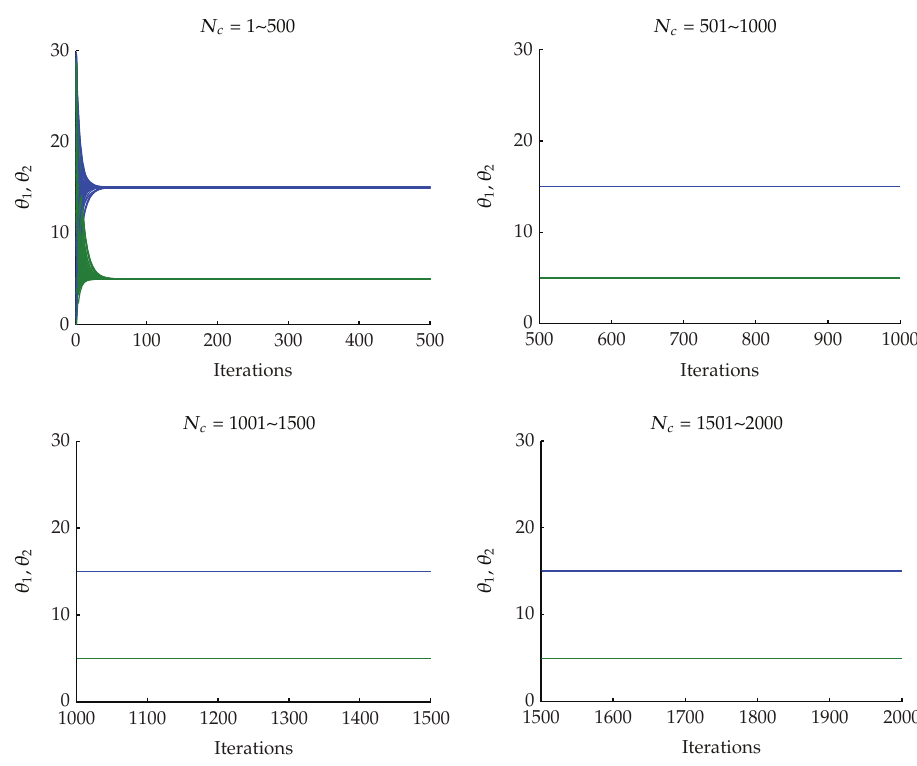
Figure 11: 2-D Position with the iteration